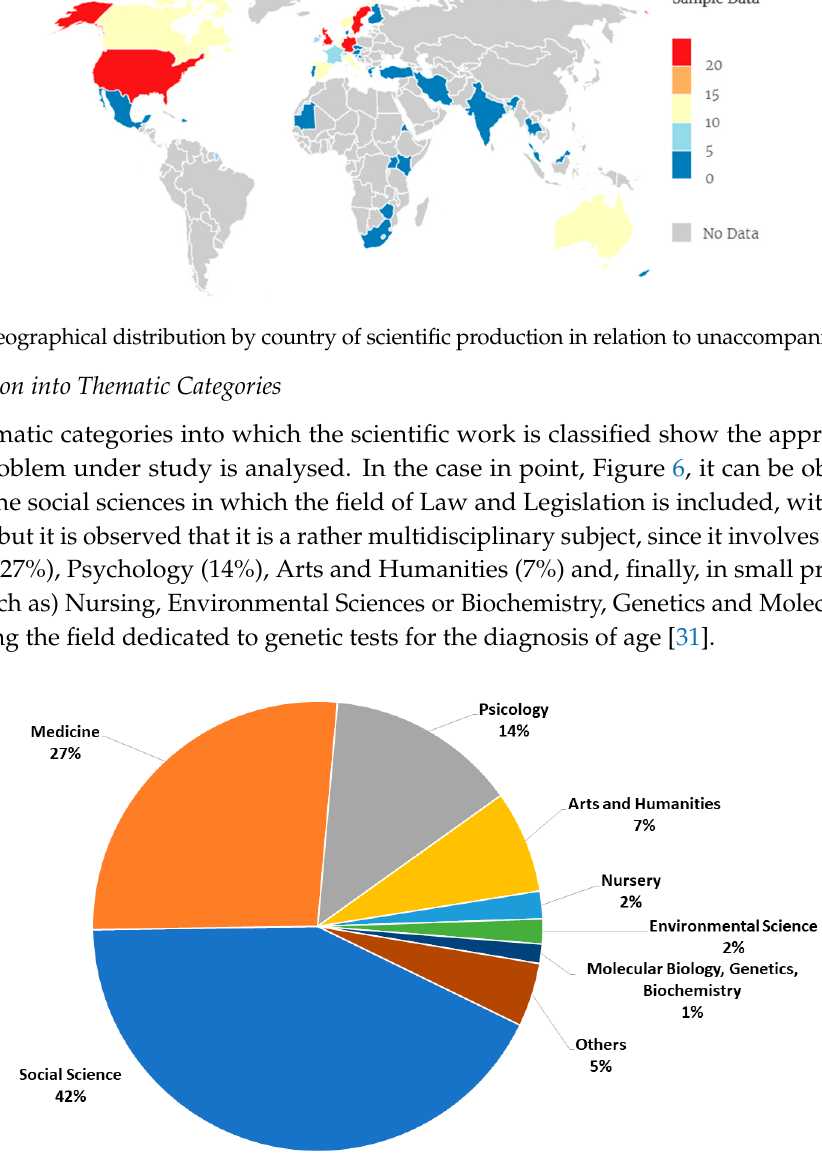
Figure 6. Distribution of scientific production in relation to unaccompanied minors by thematic category.